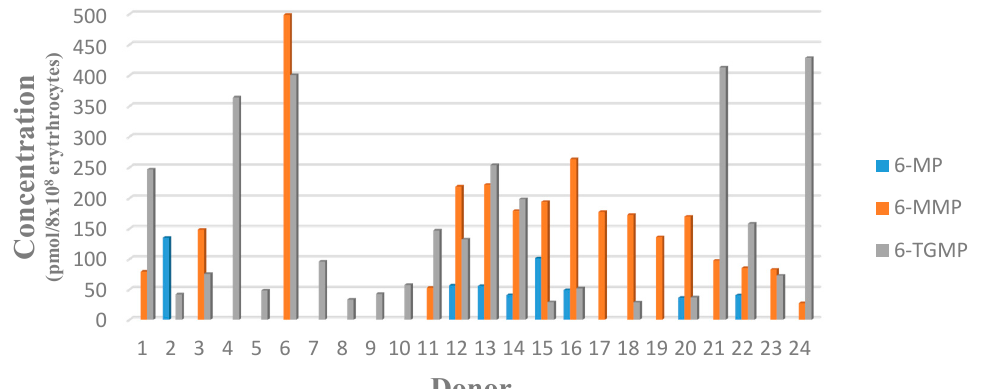
Figure 3. Concentrations of 6-mercaptopurine (6-MP), 6-methylmercaptopurine (6-MMP), and 6-thioguanosine-5’-monophosphate (6-TGMP) in dried blood spots (DBS) from 24 ALL patients. Concentrations of 6-TGMP in patients